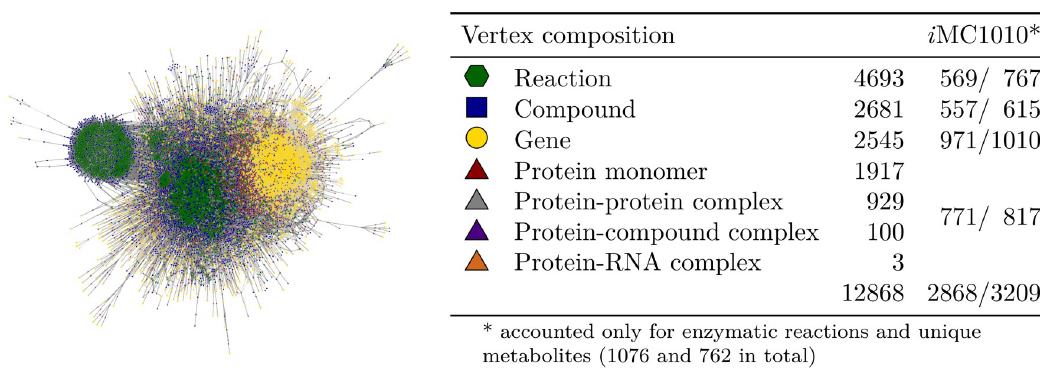
Fig 2. Spring-block graph representation and vertex composition of the integrative E. coli network. A scalable force directed placement algorithm has been used. The coverage of the pioneer model from [11] is provided in column i MC1010.